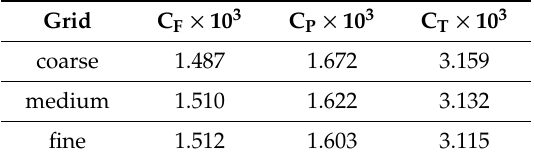
Table 8. Calculated resistance coe ffi cients at ship scale (Fr = 0.18, Re = 1.18 × 10 9